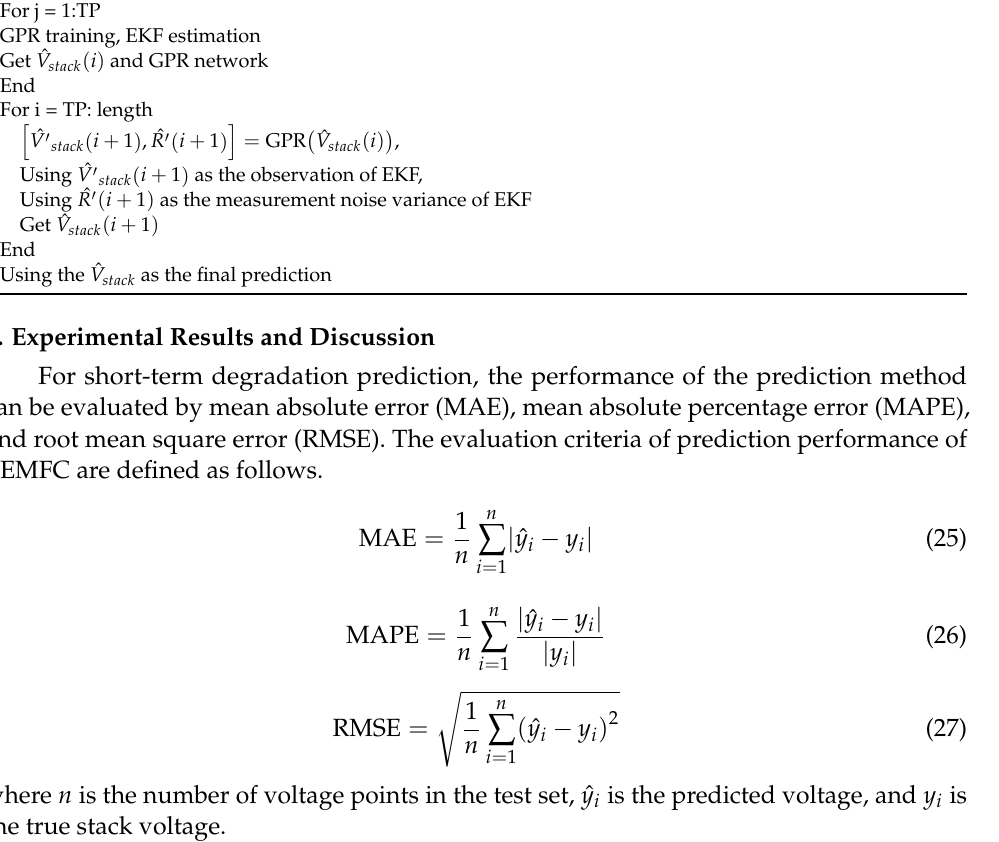
Algorithm 2: EKF-GPR Method